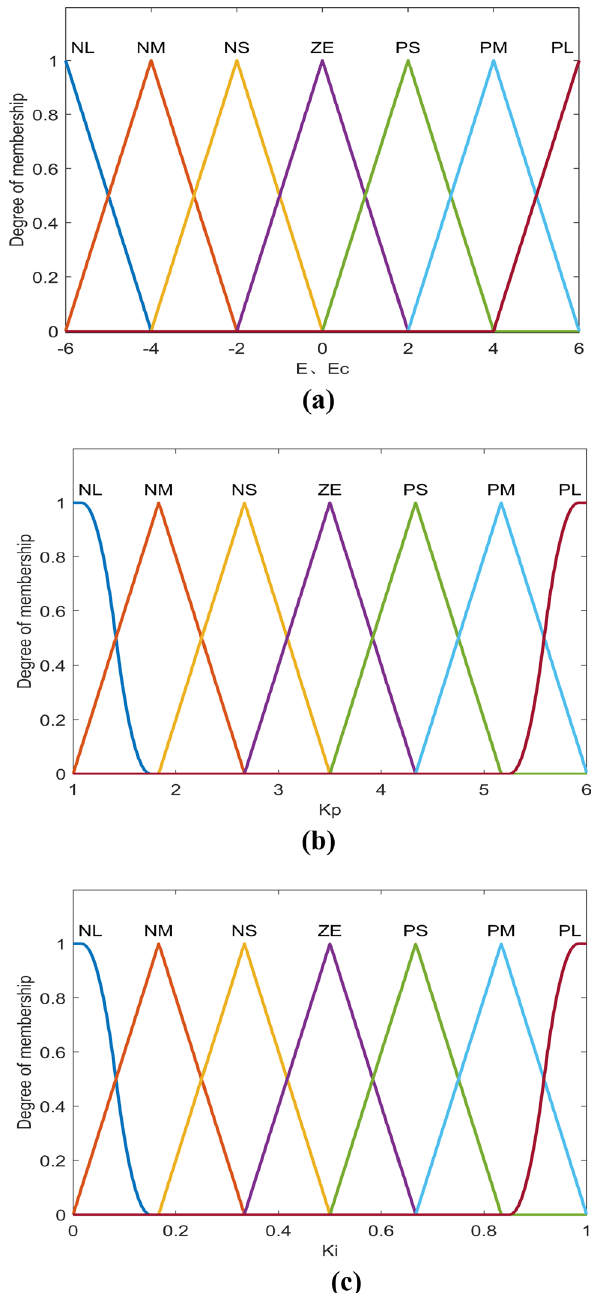
Fig. 5 PF-PI controller with proposed